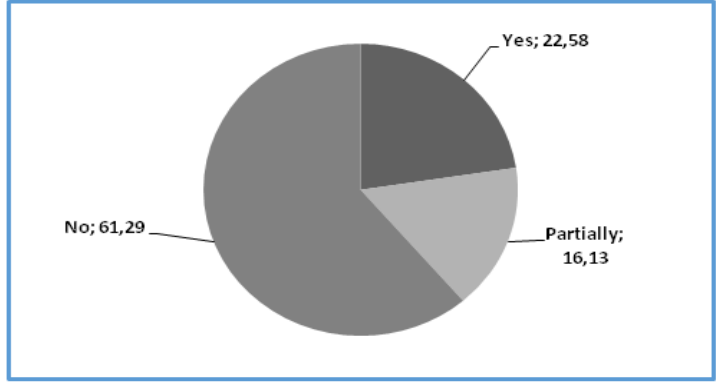
Fig. 4. Percentages of responses relative to the beginning of the session with